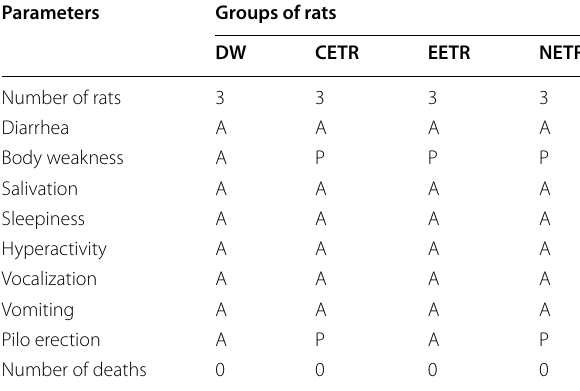
Table 2 Signs of toxicity observed in rats during 14 days acute toxicity on chloroform, ethanol or n-hexane extracts of Bombax costatum stem bark